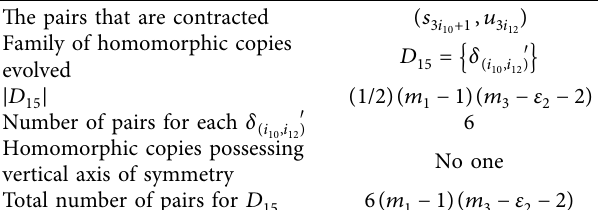
Table 14: Necessary information regarding homomorphic copies ′ 􏽮 􏽯 . δ ( i 10 ,i 12 ) The pairs that are contracted